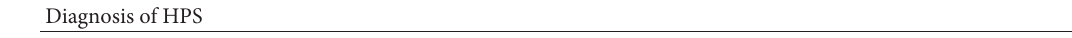
Table 1: Diagnosis criteria of HPS according to